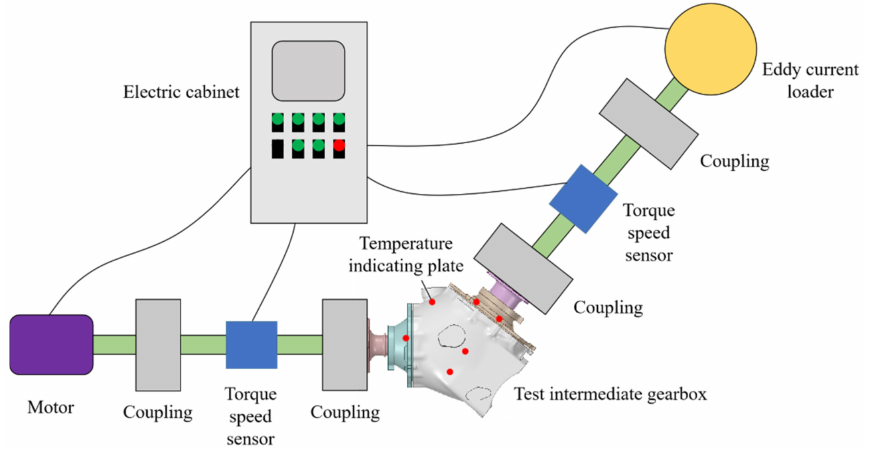
Figure 3. Schematic of experimental setup. Table 1. Fundamental parameters of spiral bevel gears.